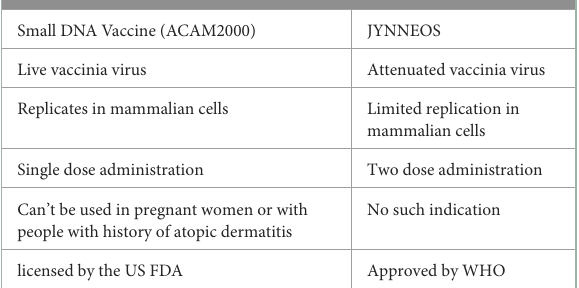
TABLE 1 Characteristics and differences between the two previously available vaccine